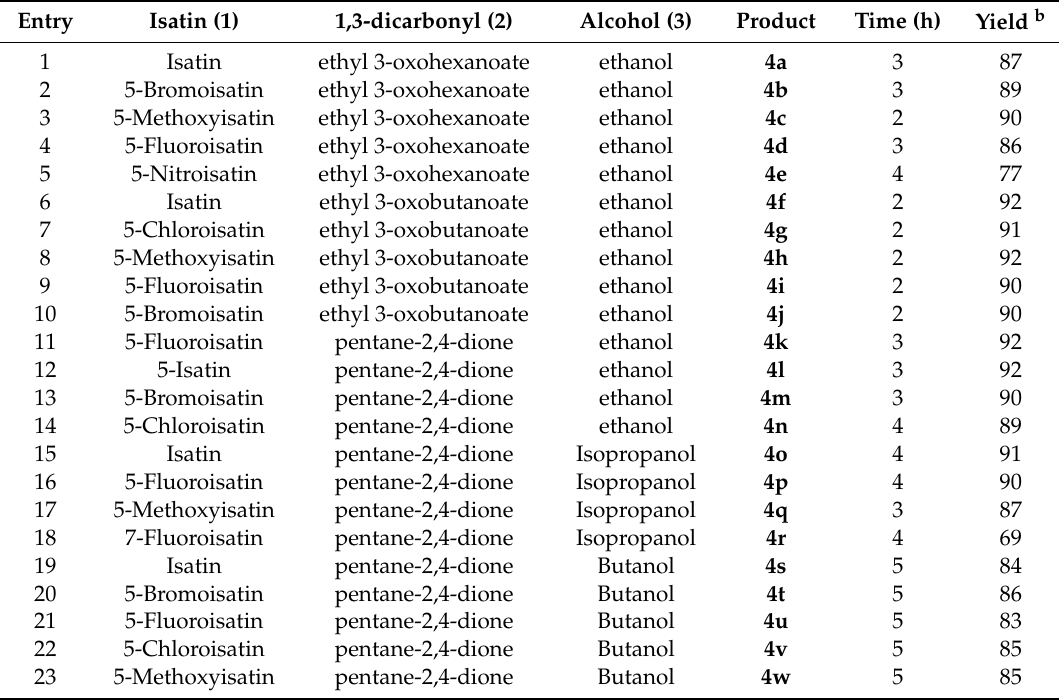
Table 3. Synthesis of quinaldine derivatives a